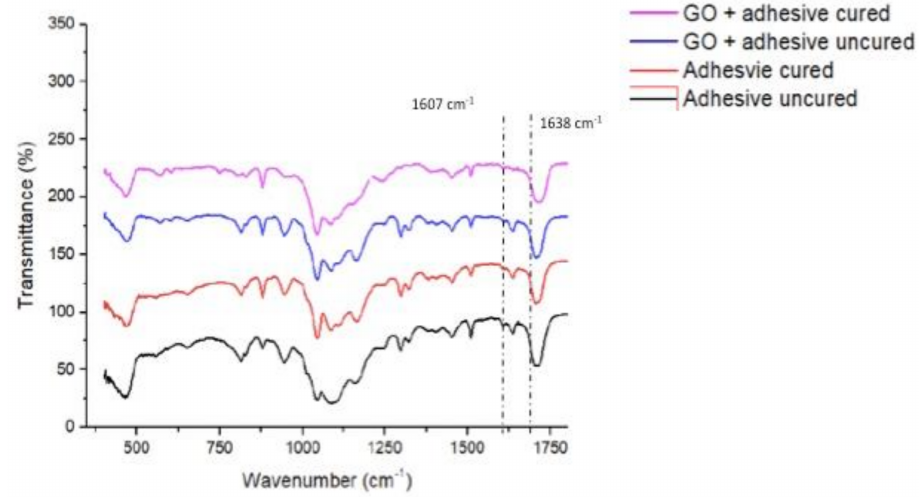
Figure 6. FT-IR spectrum of uncured and cured resin adhesives containing graphene oxide nanoparticles, and control (no nanoparticles). The degree of conversion was estimated from 1607 cm − 1 and 1638 cm − 1